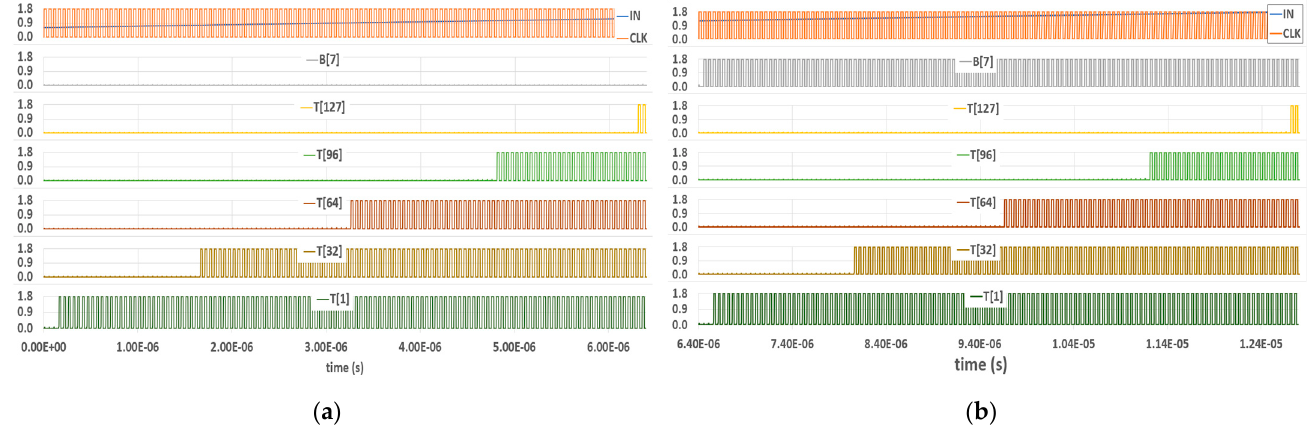
Figure 13. Comparator block post-layout simulation: (a) V in = 0.6 to 1.2 V; (b) V in = 1.2 to 1.8 V.